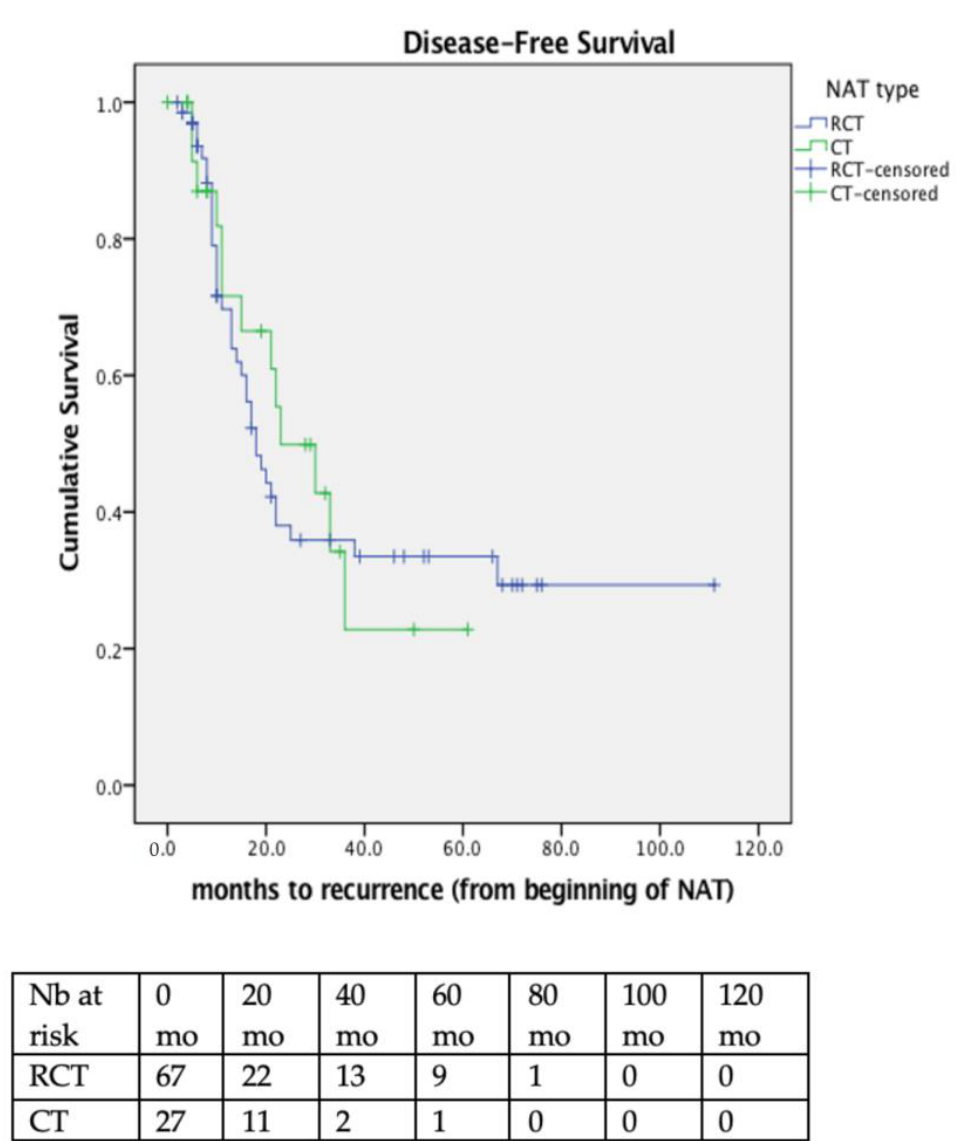
Figure 3. Disease-free survival (DFS) for all patients, according to their treatment group. Median DFS was 18 months (95%CI 13.6–22.5) in RCT and 23 months (95%CI 8.9–37.1) in CT patients. Respective 3-year DFS was 35.9% and 22.8% ( p = 0.763). NAT = Neoadjuvant treatment; RCT = radio-chemotherapy; CT = chemotherapy.